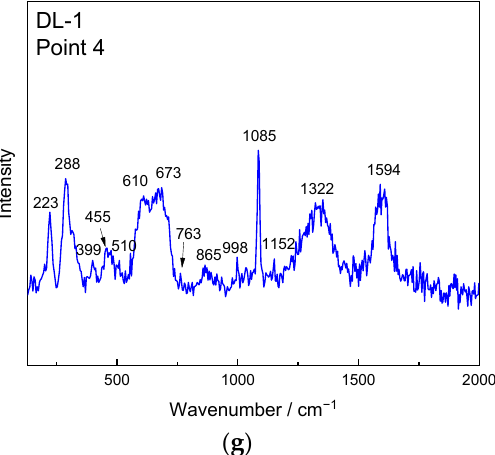
Figure 12. μ -Raman spectra of sample DL-1: ( a ) anorthite in the residual glaze, ( b ) rutile in the body, ( c ) hematite in the A-layer on the cross sections; ( d-g ) Point 1–4 on the natural surface of the cellular coagula.